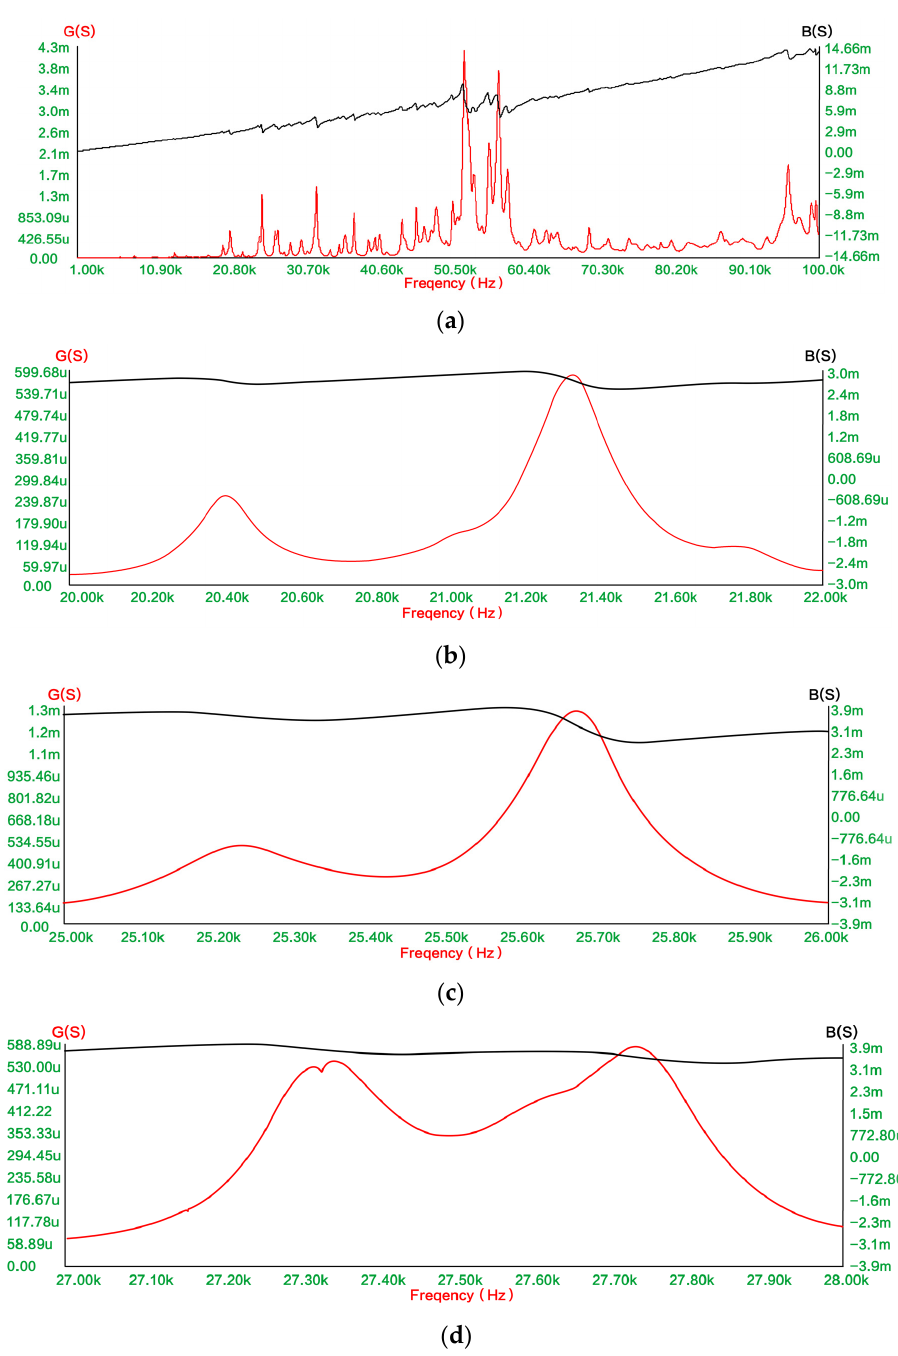
Figure 10. Measurements of the natural frequencies of the blade segment with the PZT patches. ( a ) 0~100 kHz; ( b ) 20~22 kHz; ( c ) 25~26 kHz; ( d ) 27~28 kHz.